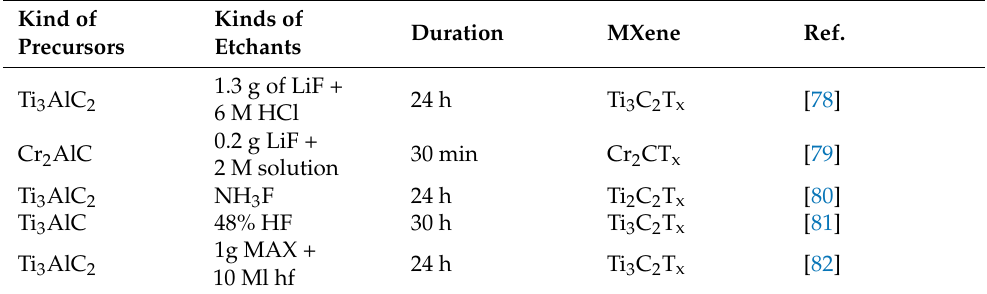
Figure 2. Synthesis of ways to produce DL-Ti 3 C 2 T x by direct HF and in situ HF approach [38]. Table 1. Fabrication of different MXenes.